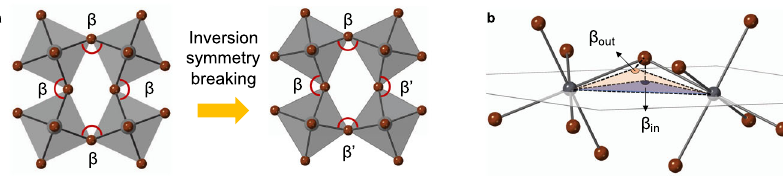
Fig. 1 Symmetry breaking in 2D MHPs. a Schematic showing symmetric (left) and asymmetric (right) tilting of MX 6 octahedra. Symmetric titling leads to a single M – X-M bond angle ( β ) and maintains inversion symmetry. Asymmetric tilting breaks the inversion symmetry by creating two M – X-M bond angles